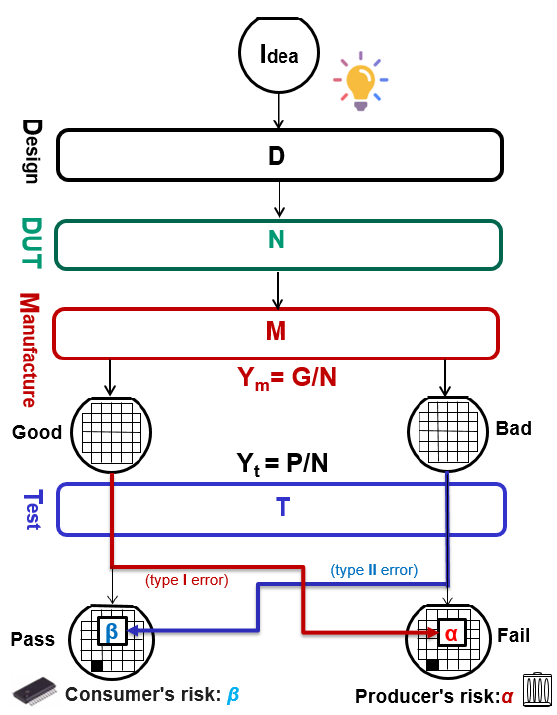
Figure 1. Manufacturing and testing processes containing test errors.